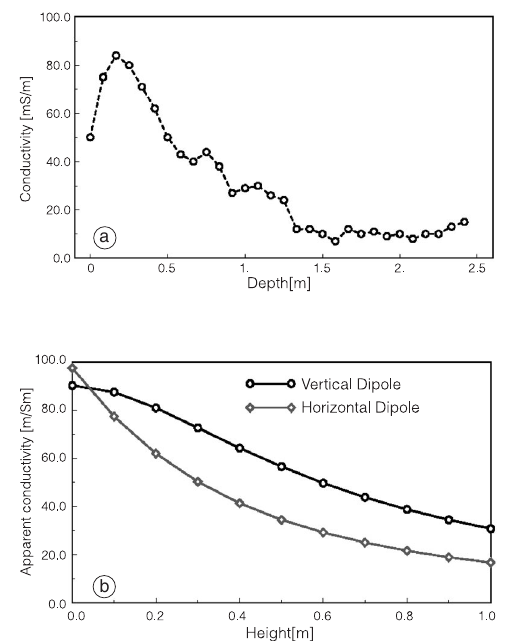
Fig. 4a,b. a) Synthetic ground conductivity profile; b) apparent conductivity data computed from the ground conductivity profile in